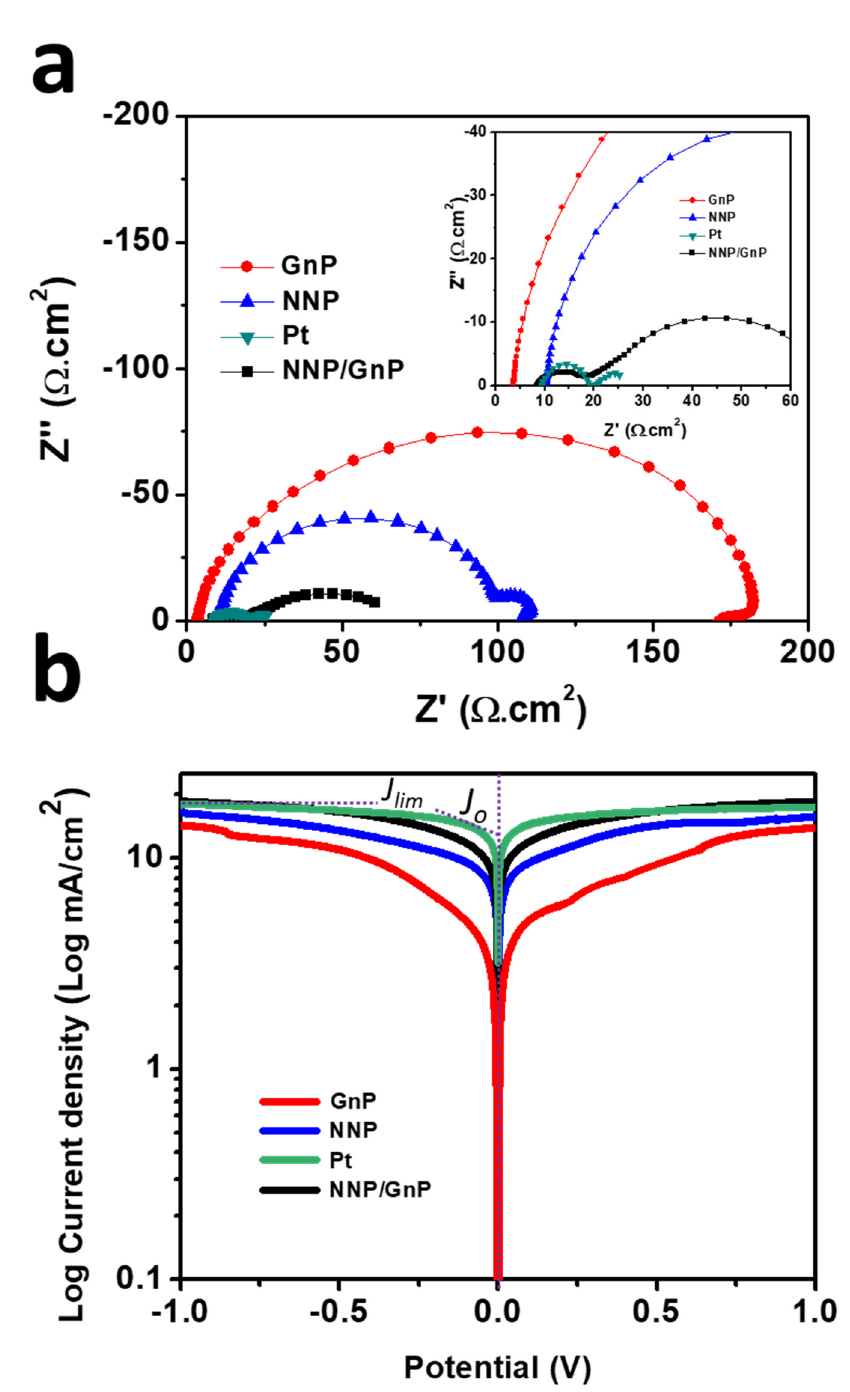
Figure 5. ( a ) Nyquist plots of symmetrical dummy cells, measured at 0 V under dark conditions (inset shows the magnified Nyquist plot at the high-frequency region) and ( b ) Tafel polarization plots of the symmetrical dummy cells based on different CEs. Tafel polarization plots of the dummy cells, similar to the one used for EIS, were measured to elucidate the electrochemical activity of the CEs further (Figure 5b). The ex- change current density ( Jo ), calculated from the intercept of the linear fitting lines in the polarization curves [11], were 13.72, 10.80, 8.50, and 3.40 mA/cm 2 , respectively, for Pt-, NNP/GnP-, NNP-, and GnP-CEs, respectively. This result further suggests the better cat- alytic activity of NNP/GnP-CE for I − /I 3 − electrolyte than the NNP- and GnP-CEs and is slightly lower than the Pt-CE. The corresponding diffusion coefficient ( D n ) of I − /I 3 −